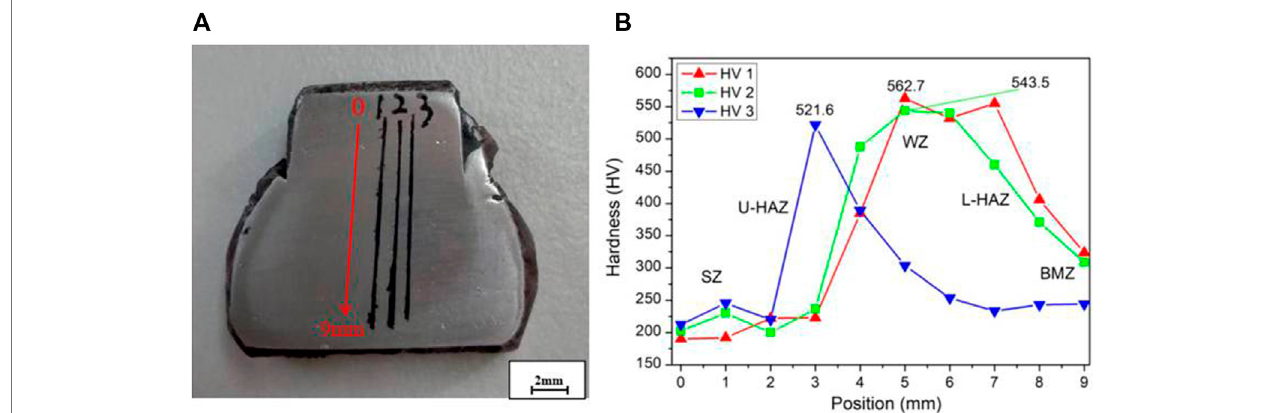
FIGURE 4 | Position (A) and result (B) of micro-hardness test for FSW joint.